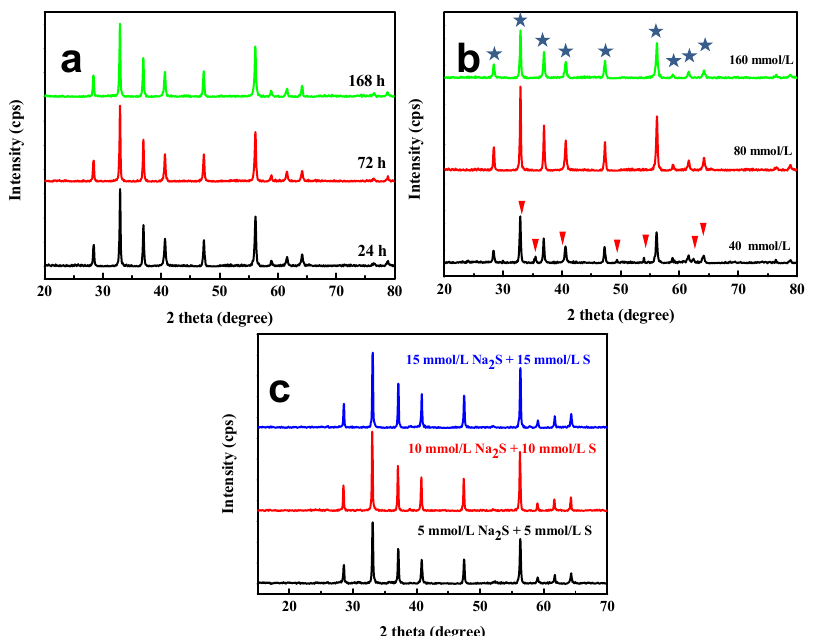
Figure 2. ( a ) XRD patterns of pyrite samples prepared at different hydrothermal times in 80 mmol/L thiourea solution; ( b ) XRD patterns of samples prepared at 24 h with different concentrations of thiourea, : pyrite, : hematite; and ( c ) XRD patterns of the as-synthesized pyrite at 24 h with different concentrations of Na 2 S and S powder as the sulfur source.